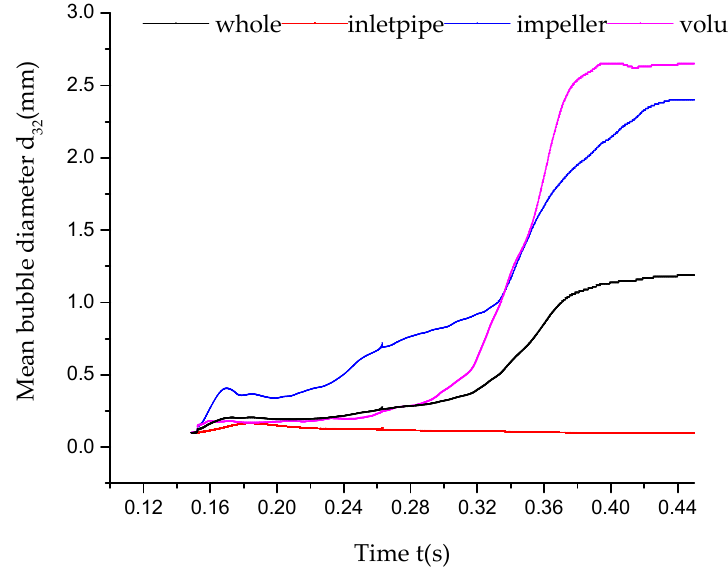
Figure 16. Variation of the mean diameter with time of the main pump components in the coalescence